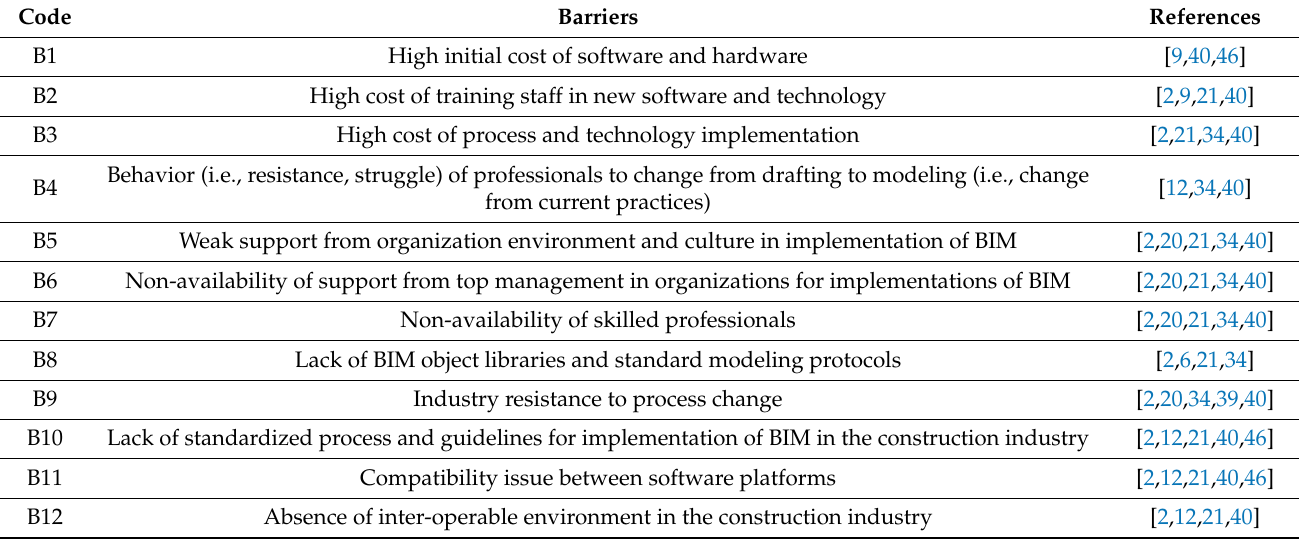
Table 2. Potential barriers to BIM